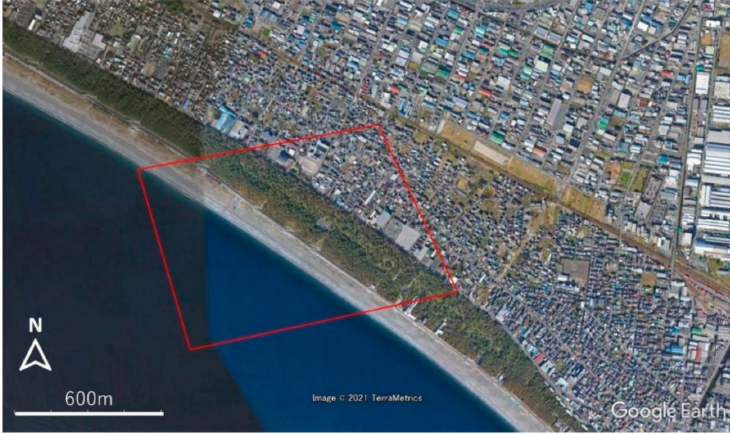
Figure 1. An example of one of the target sites along the Fuji coast. The background image was obtained from Google Earth. The red rectangular frame indicates the area shown in Figure